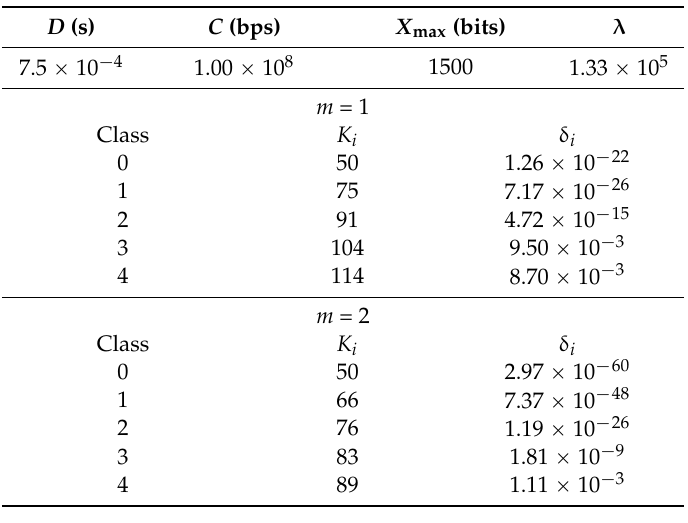
Table 1. Parameters for the Fractional Service Buffer (FSB) design example, and comparison on